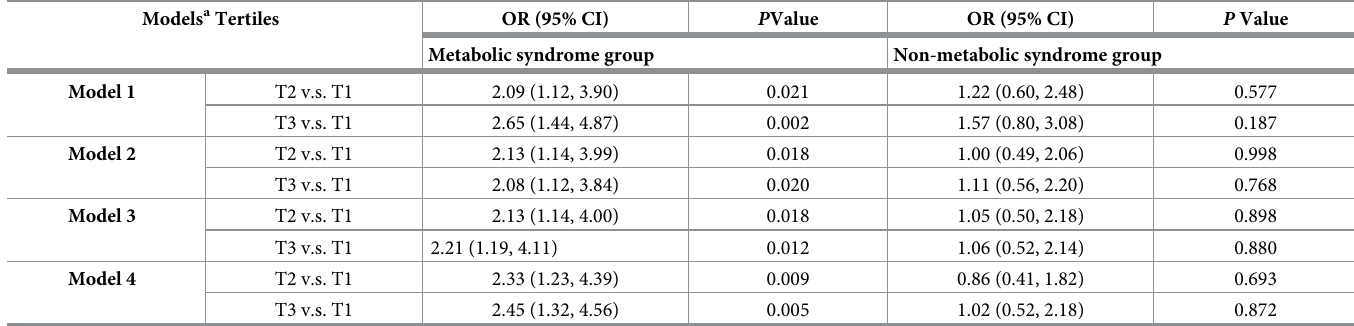
Table 2. Association between frailty and serum LDH level in study participants with MetS and non-MetS. Models a